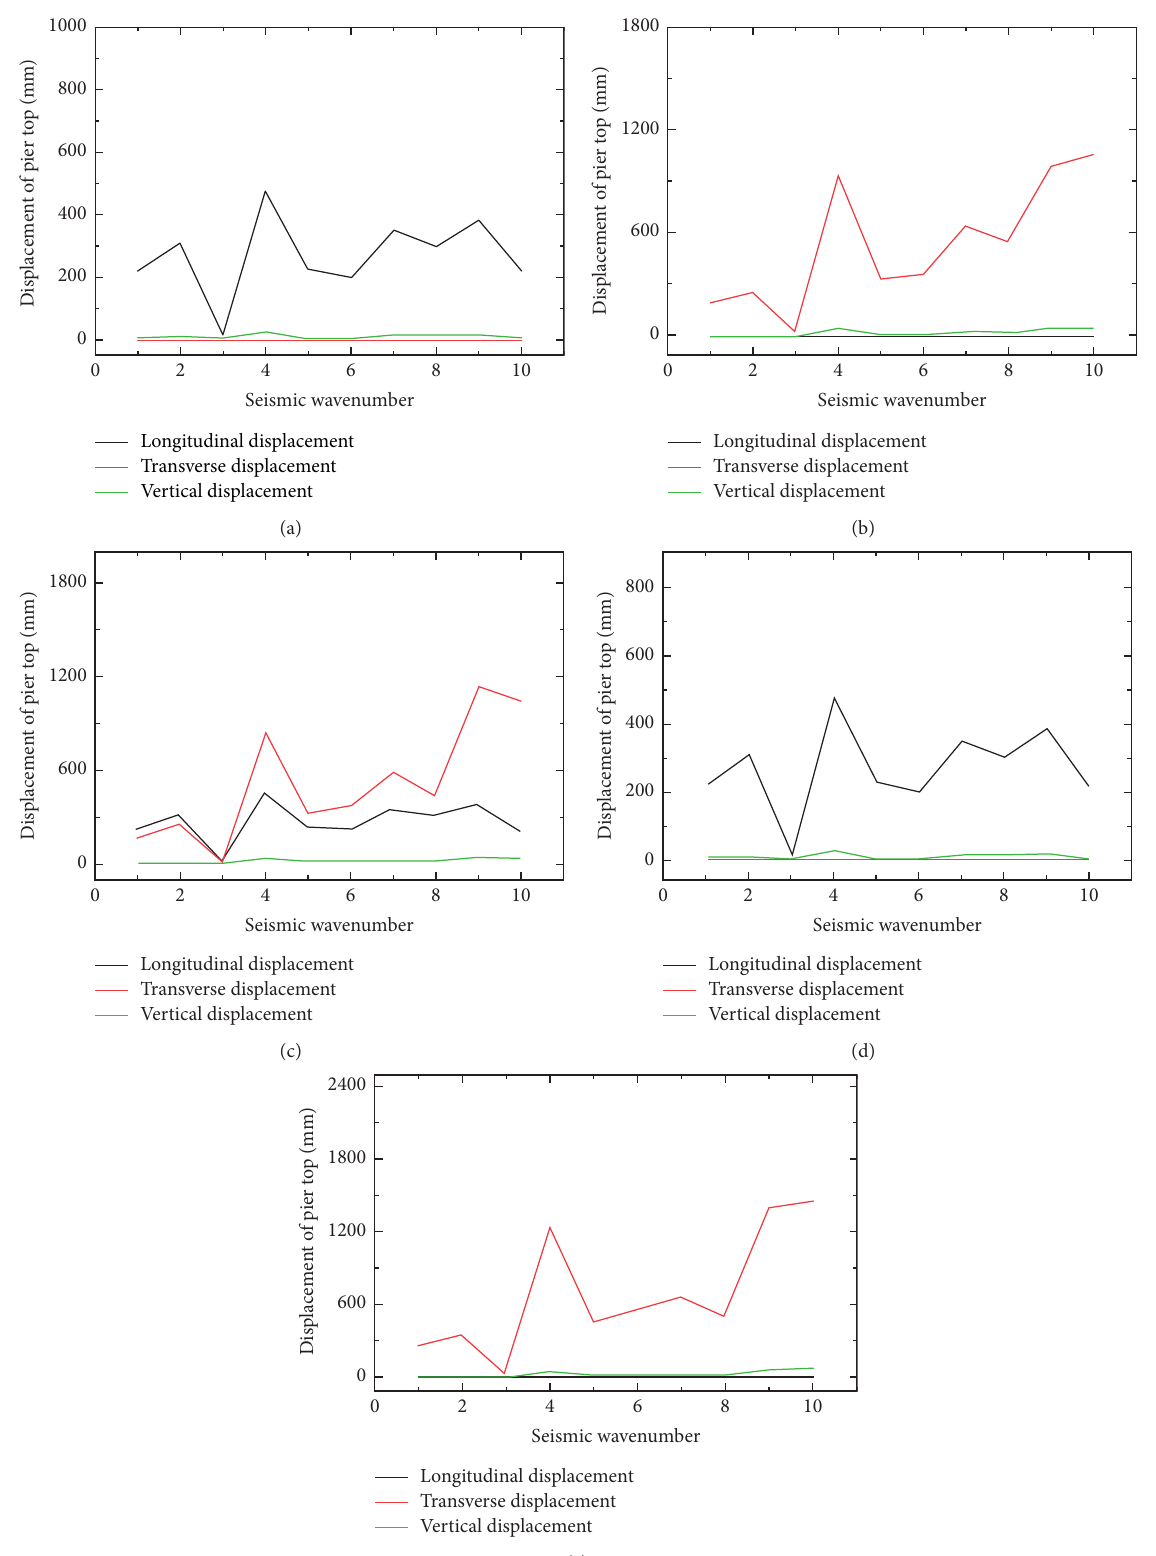
Figure 2: Maximum displacement of pier top under different seismic action combinations: (a) longitudinal action; (b) transverse action; (c) longitudinal and transverse simultaneous action; (d) longitudinal and vertical simultaneous action; (e) transverse and vertical si- multaneous